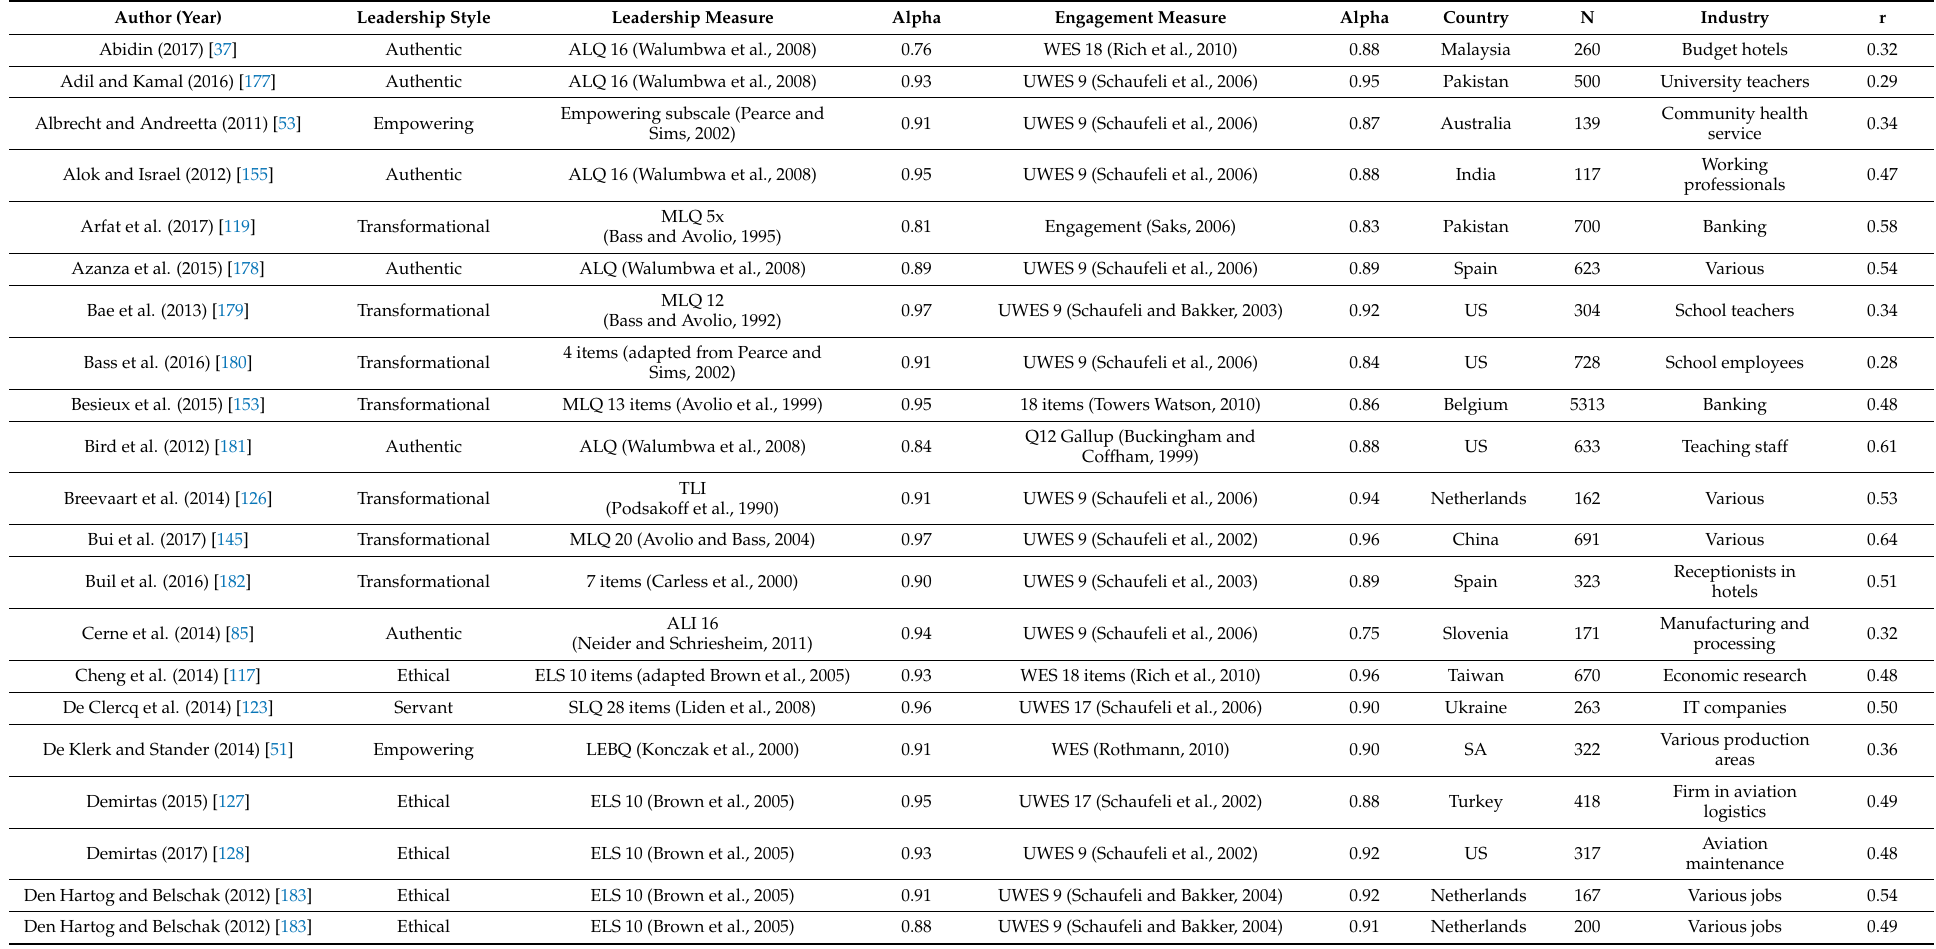
Table A1. Study information from meta-analysis